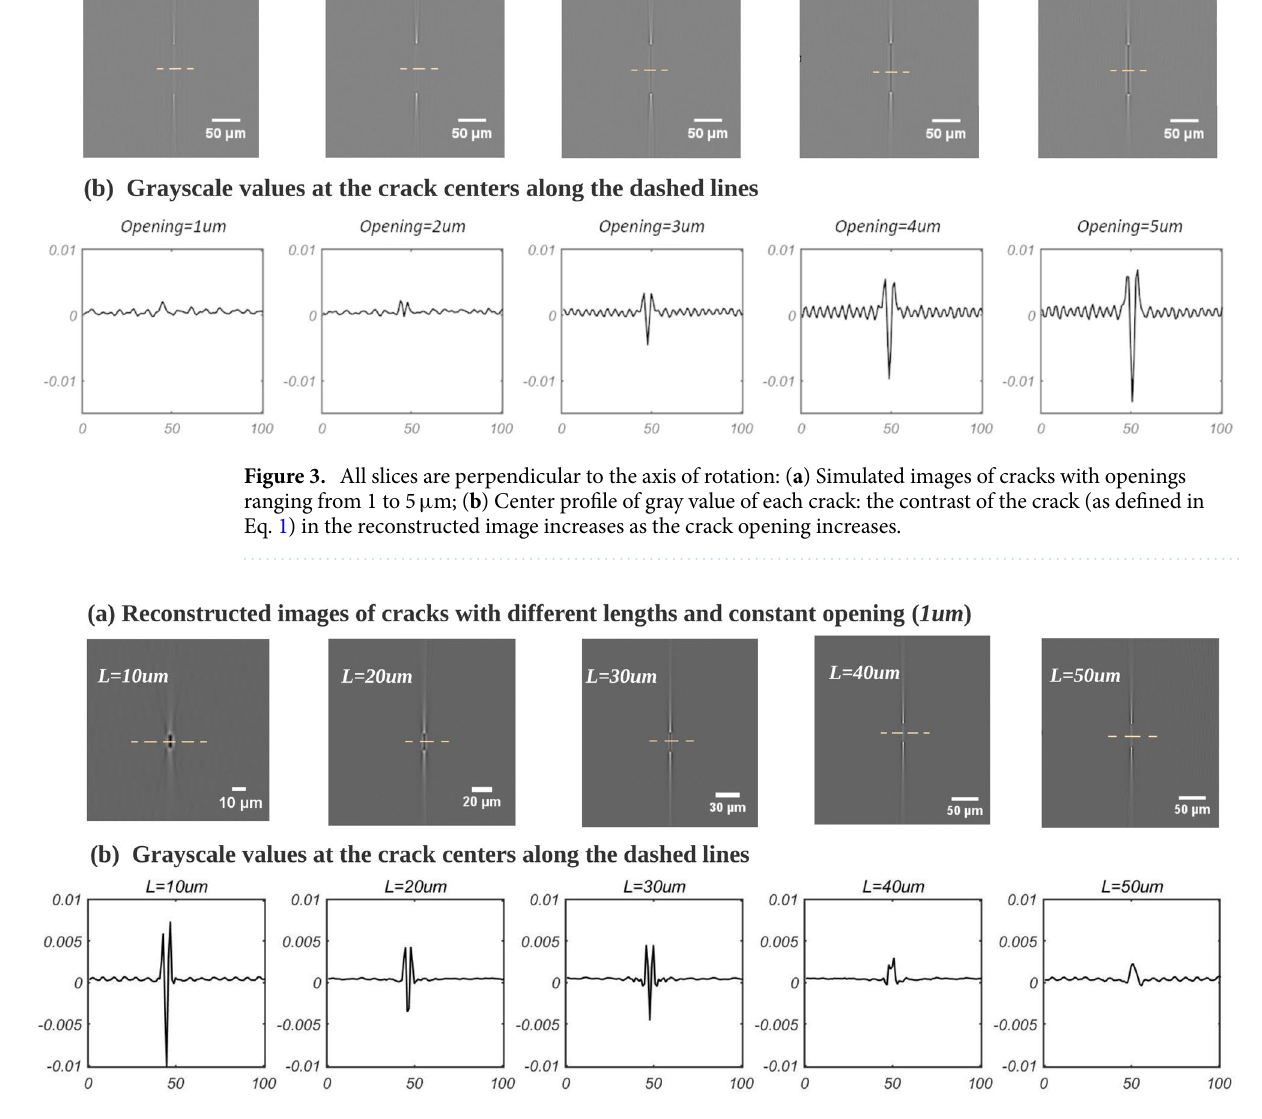
Figure 4. All slices are perpendicular to the axis of rotation: ( a ) The simulated image of cracks with different lengths, 10–50 µ m; ( b ) Center profile of gray value of each cracks: the contrast of the crack (as defined in Eq. 1) in the reconstructed image decreases as the crack length